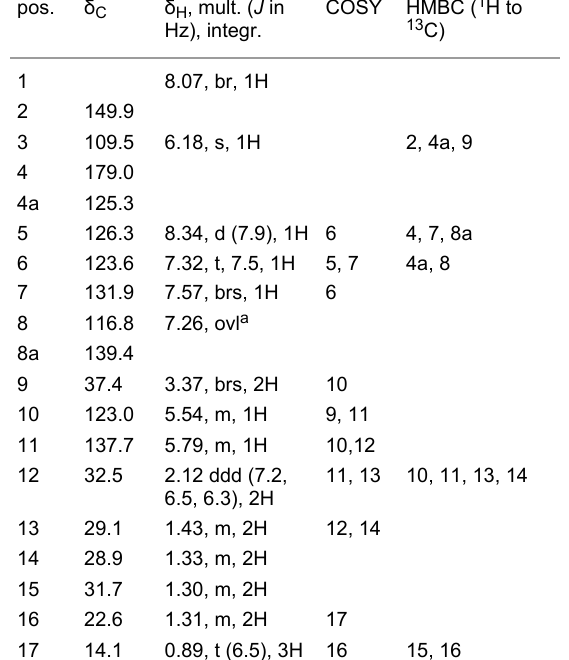
a Signal overlapped by a residual solvent peak.